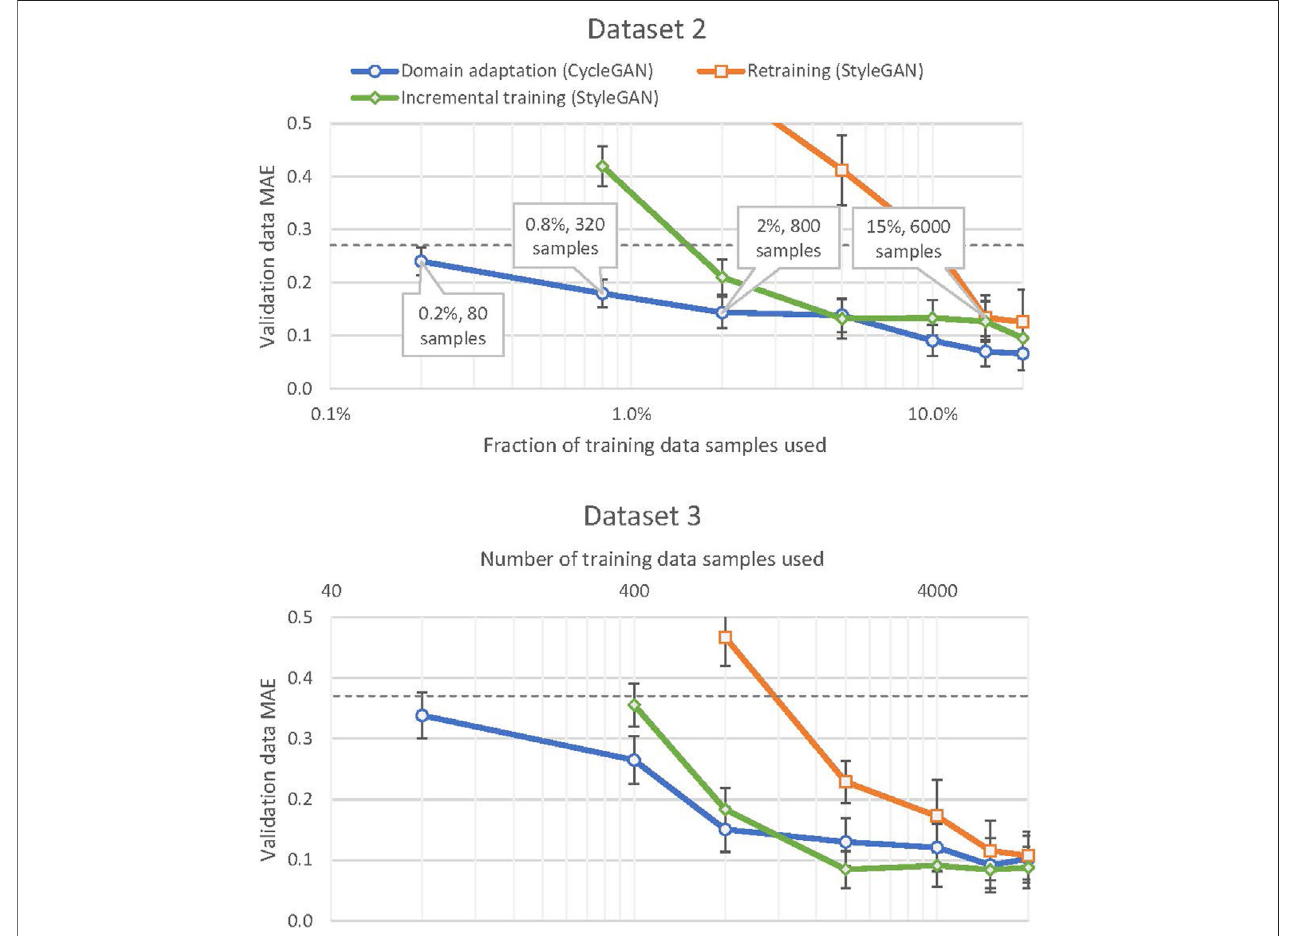
FIGURE 6 | Model error ( Y -axis) plotted against the amount of data ( X -axis, log scale) used for training the networks under the three approaches, separated by target domain dataset. The vertical error bars indicate the standard deviation of the model error across several runs under the same conditions. The dashed horizontal lines on both subcharts represent the errors (cid:2) E thld of the models trained on dataset 1 when evaluated against dataset 2 and 3 validation data